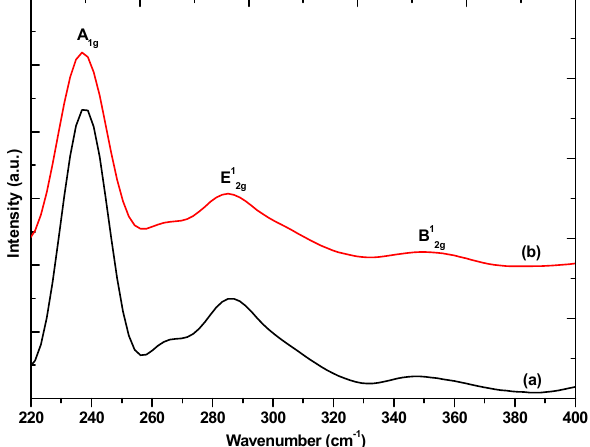
Figure 2. Raman spectra of (a) MoSe 2 nanosheets and (b) MoSe 2 nanoflowers.